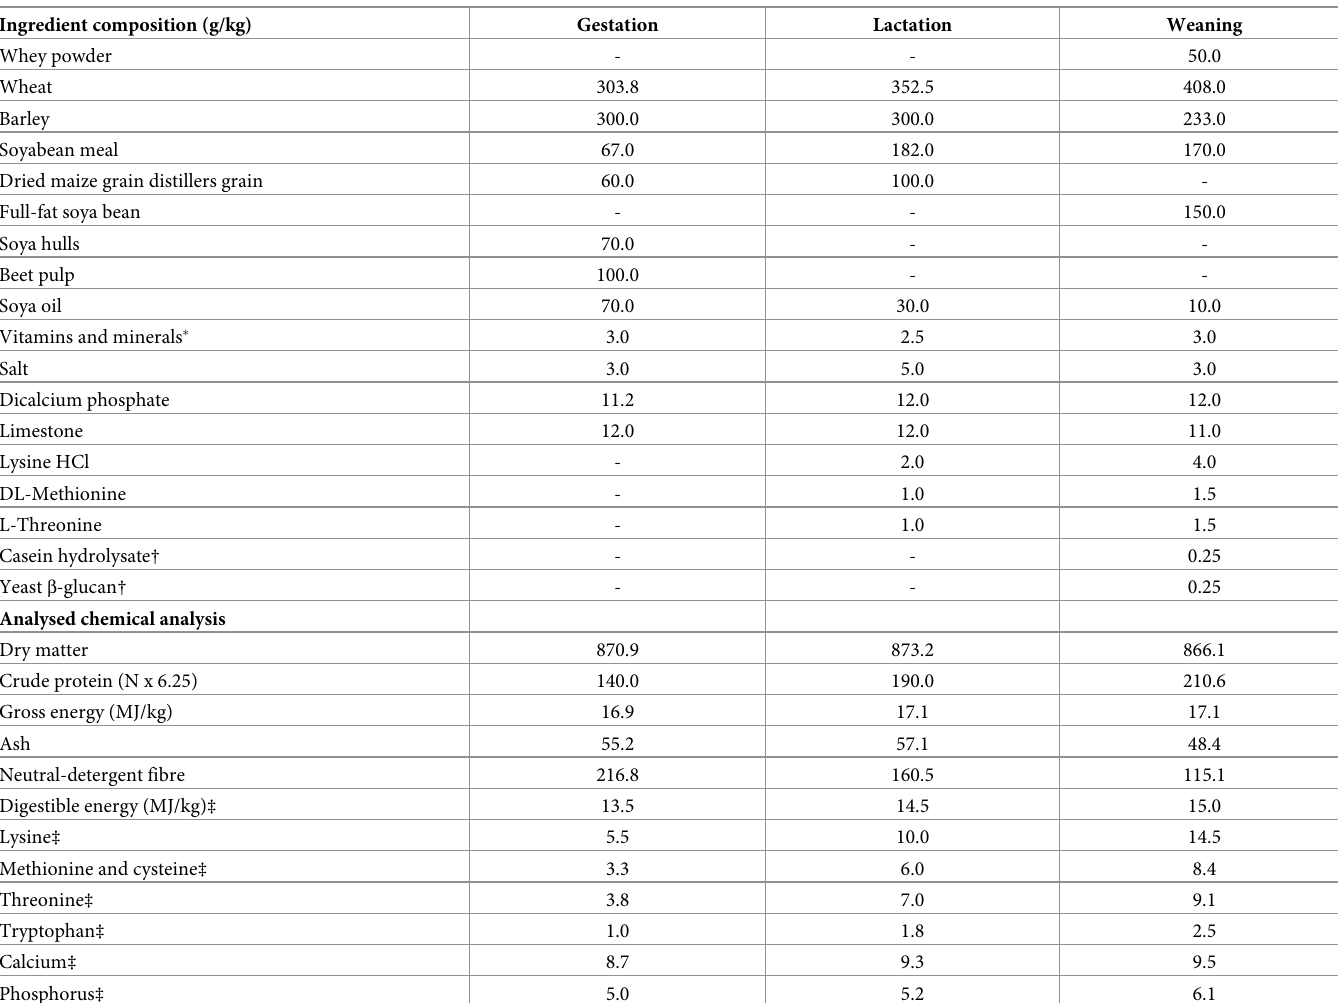
Table 1. Ingredient and chemical composition of gestation and lactation